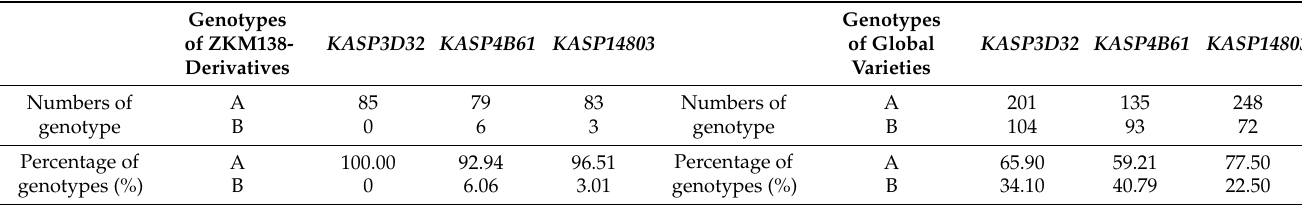
Table 5. The genotype distribution of R3D, R4B.1 and R6D2 in the derivatives of ZKM138 and global